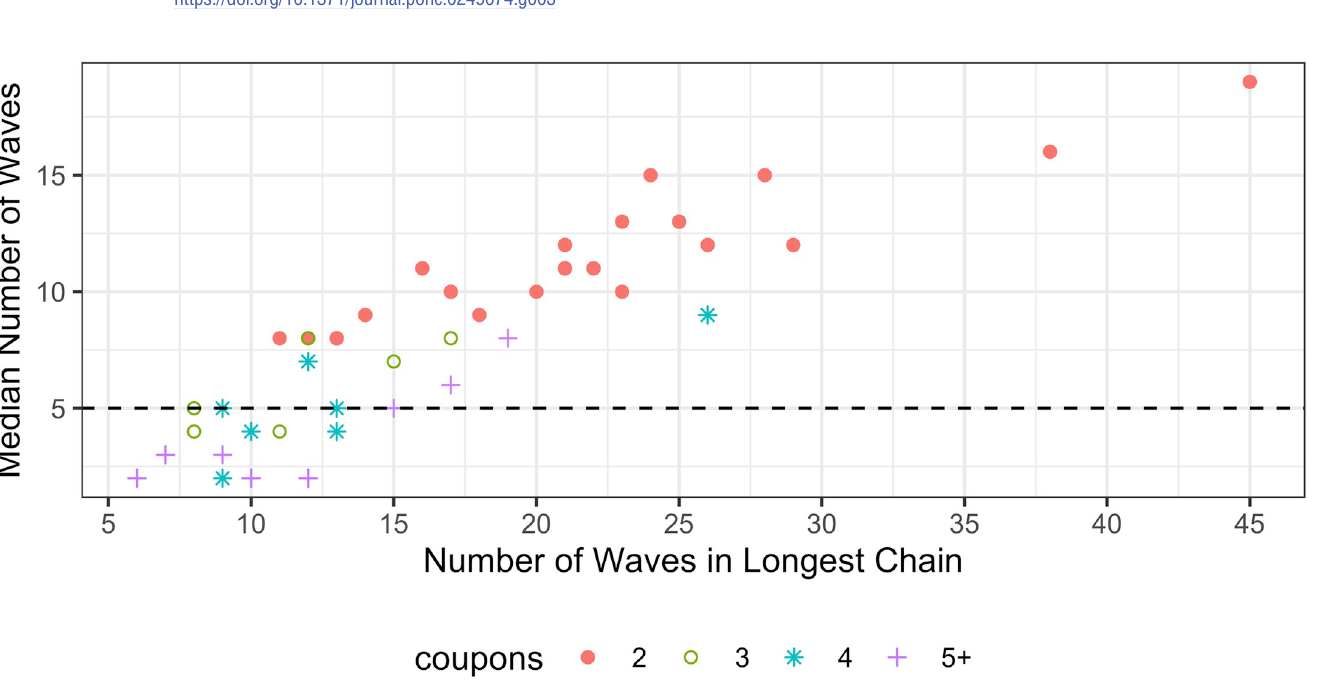
Fig 4. Recruitment waves. Relationship between the number of waves in the longest recruitment chain and the median number of waves across all studies. Each study sample is represented by one data point.